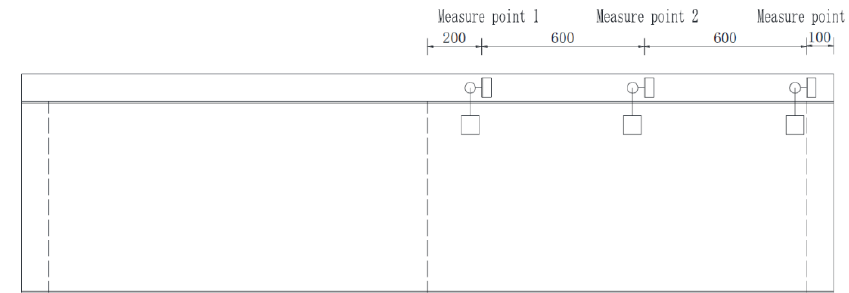
Figure 6. Layout of Dial Gauge (unit: mm).